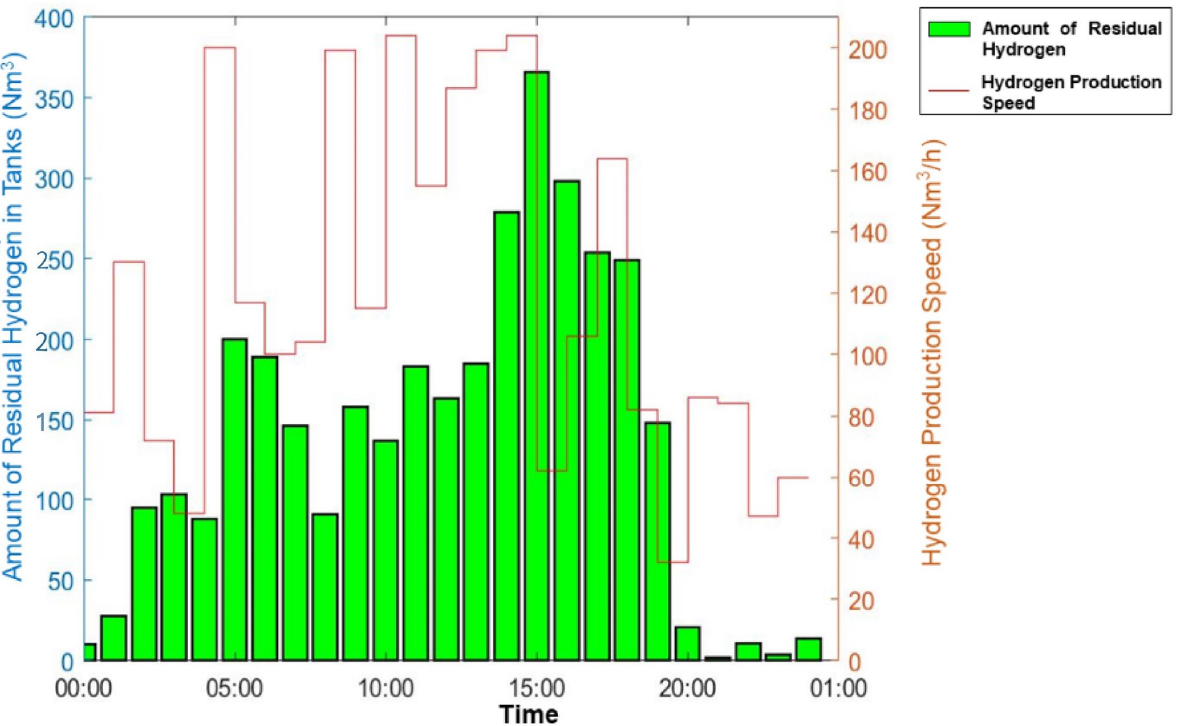
Figure 5. Hydrogen production speed of electrolyzer and remaining hydrogen amount in stor- age